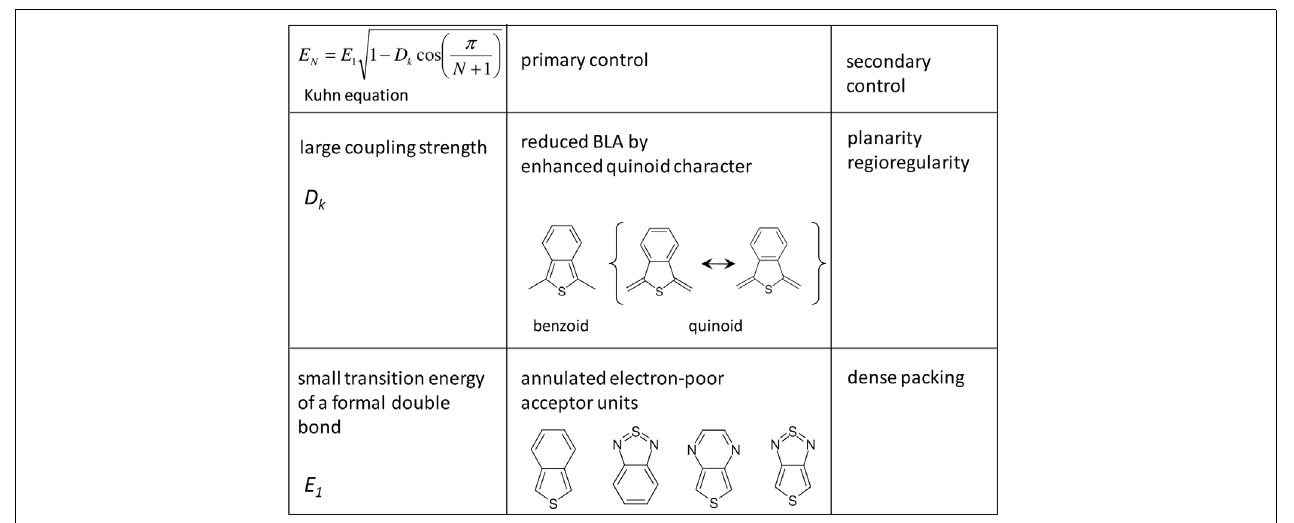
FIGURE 2 | Parameters of the Kuhn equation and their primary and secondary control in conjugated (co)polymers.